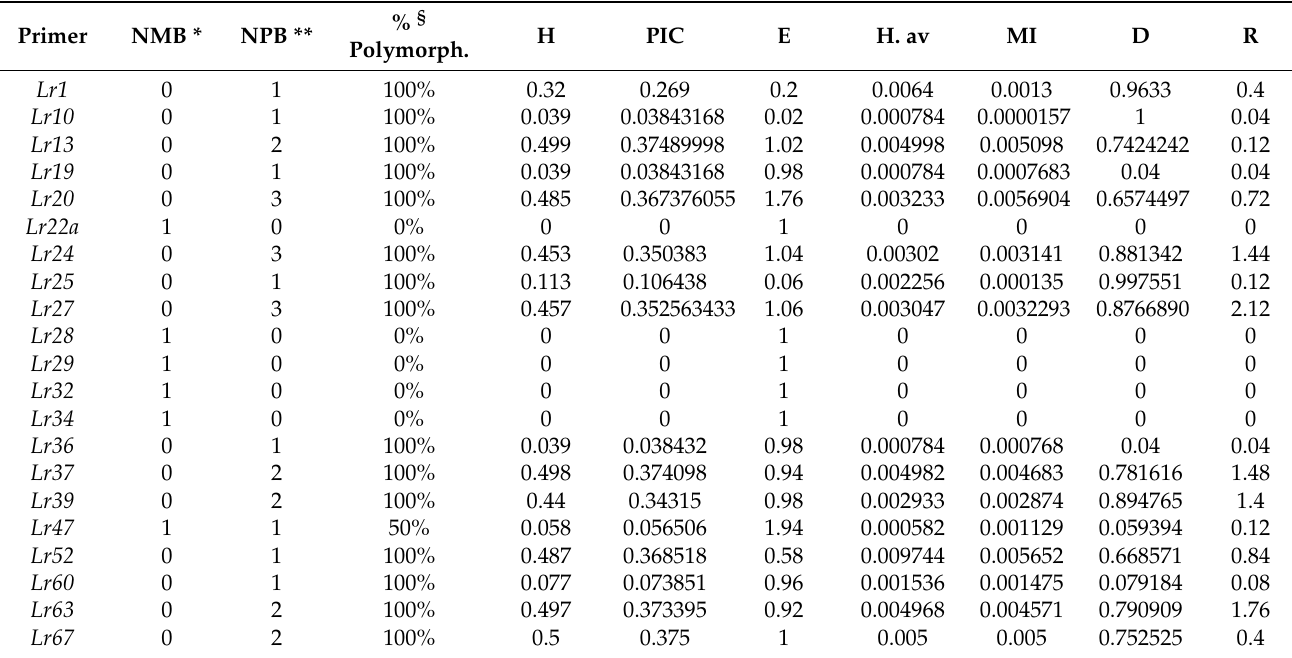
Table 5. Primers, number of monomorphic bands, number of polymorphic bands, percentage of polymorphism, and marker efficiency parameters of leaf rust resistance